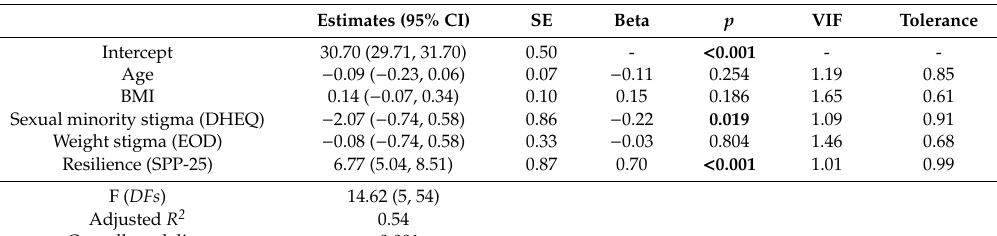
Table 3. The predictors of self-esteem for All sample (N = 60) tested by linear regression